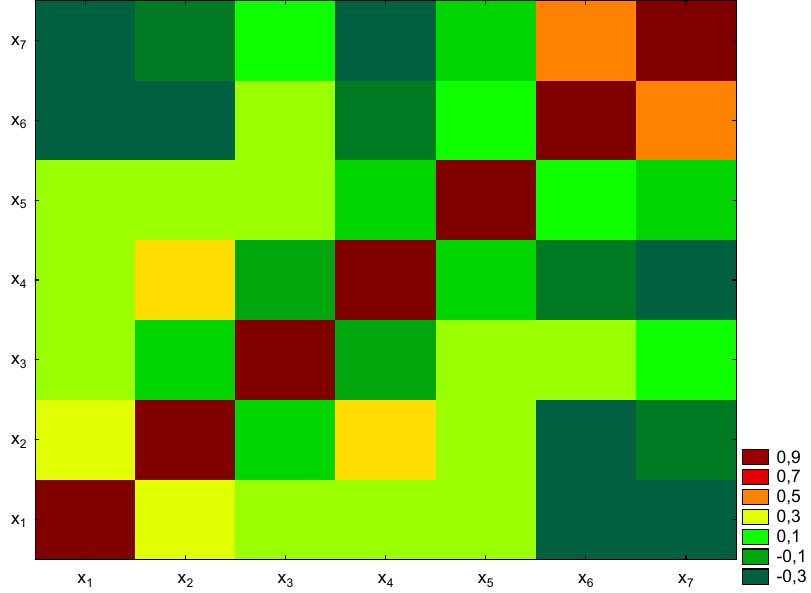
Figure 3. Three-dimensional sequential graph Spearman rank-order correlations in Workbook1 7v*7c.